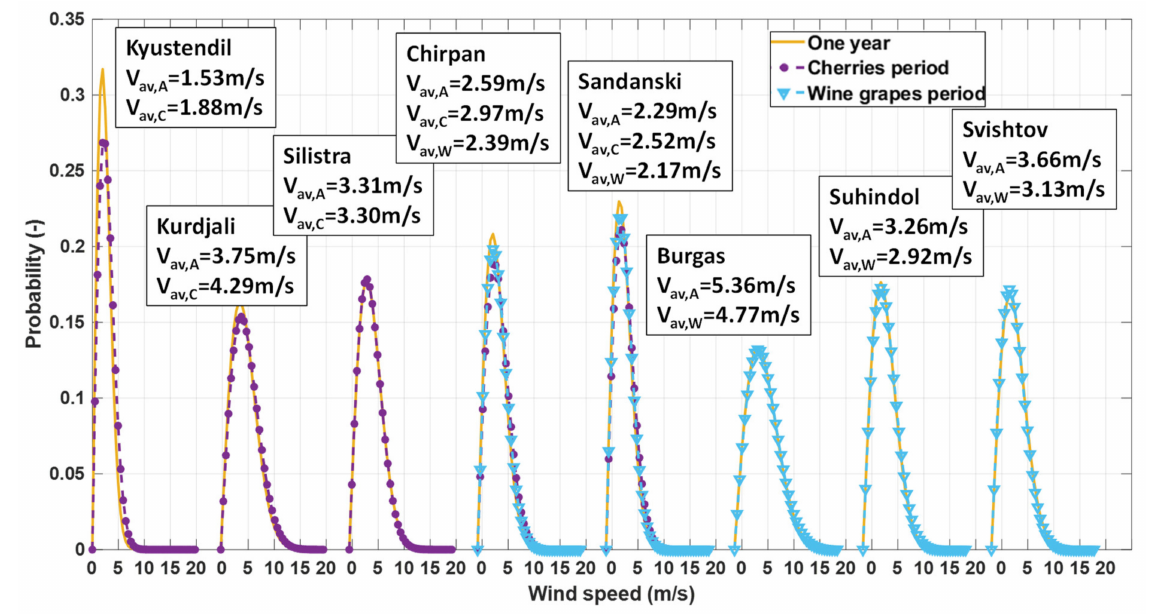
Figure 8. Weibull distribution for the considered sites for one year (yellow solid line), the cherry irrigation period (purple dashed line with rounds) and the wine grape/period (blue dashed line with triangles), and the corresponding average wind speeds: V av,A , V av,C and V av,W .